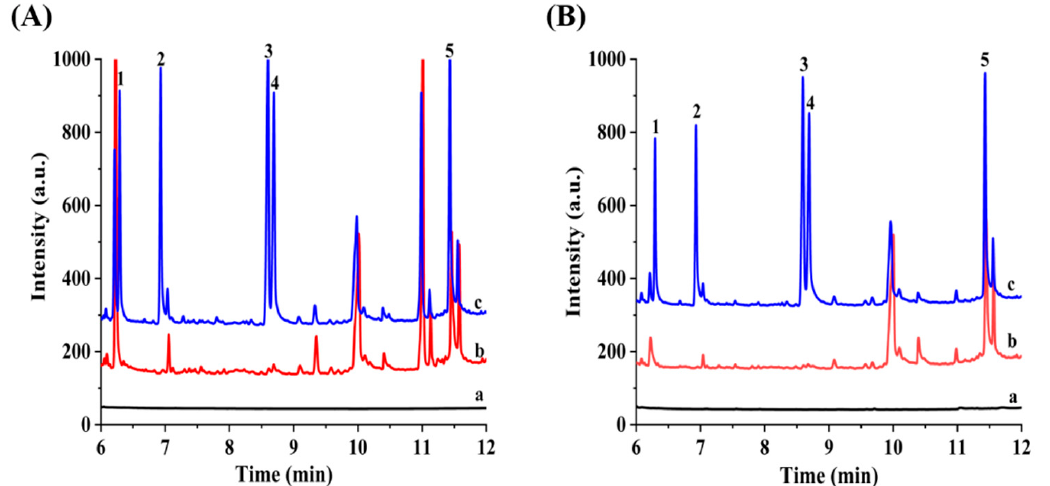
Figure 5. Typical chromatograms obtained for the analysis of campus soil ( A ) and Zhengkai Avenue soil ( B ) with different methods. Direct inject extract of blank soil with a volume of 1 µ L (a), the extract of blank soil (b) and spiked soil (400 ng g − 1 ) (c) pretreated with developed SPME-GC-FID using h-BN as fiber coating. Peaks identification: (1) ACE, (2) FLU, (3) PHE, (4) ANC and (5) PYR.